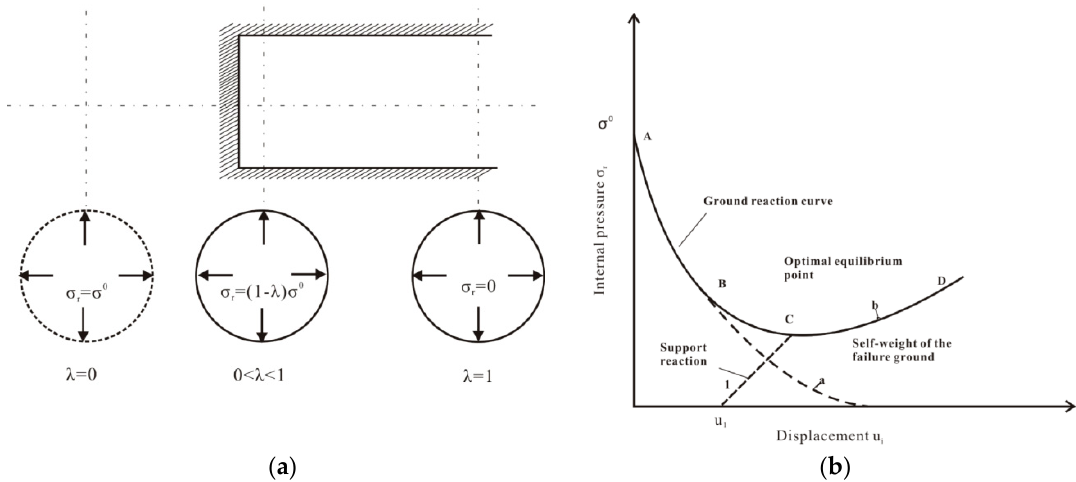
Figure A1. Convergence confinement method: ( a ) evolution of tunnel convergence with face advance; ( b ) ground reaction curve and support reaction curve (adapted from Orestes [13]).